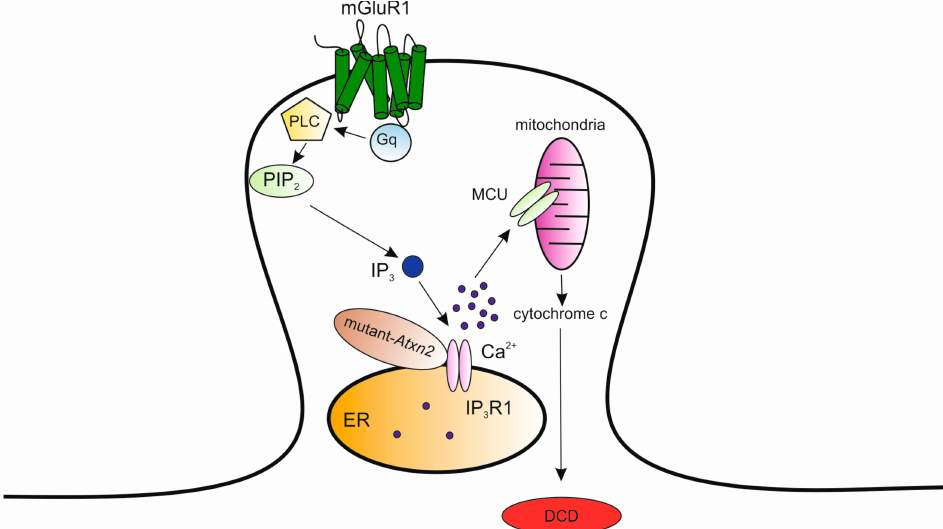
Figure 3. The IP 3 receptor type 1 (IP 3 R1)-mutant Atxn2 interaction-induced cell death. The IP 3 R1–mutant ataxin-2 ( Atxn 2) interaction results in increased IP 3 R1 activity. The abnormal Ca 2 + signaling determines mitochondrial Ca 2 + overload, release of cytochrome C and, consequently, induction of Purkinje cell death via dark cell degeneration (DCD). Modified from